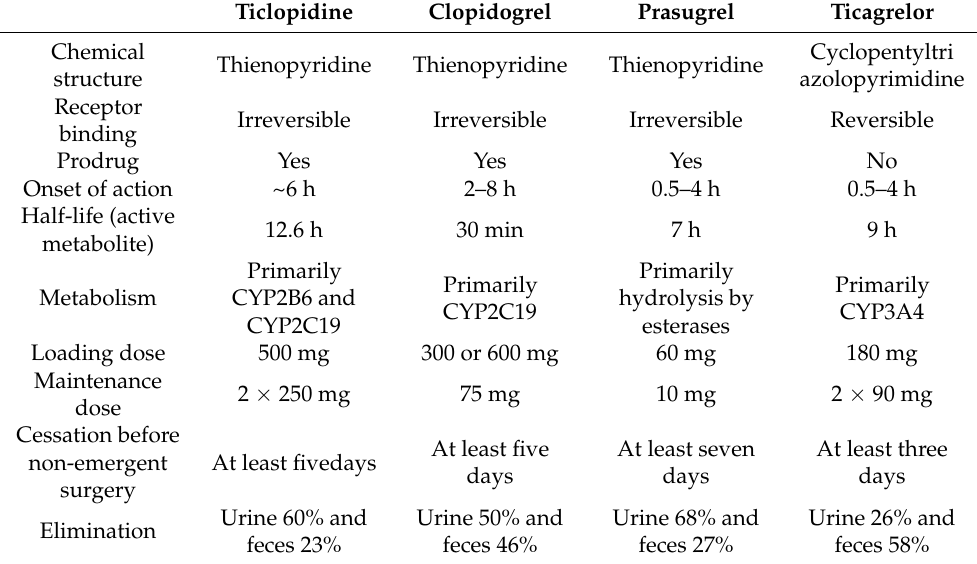
Table 2. Characteristics of oral P2Y12 inhibitors